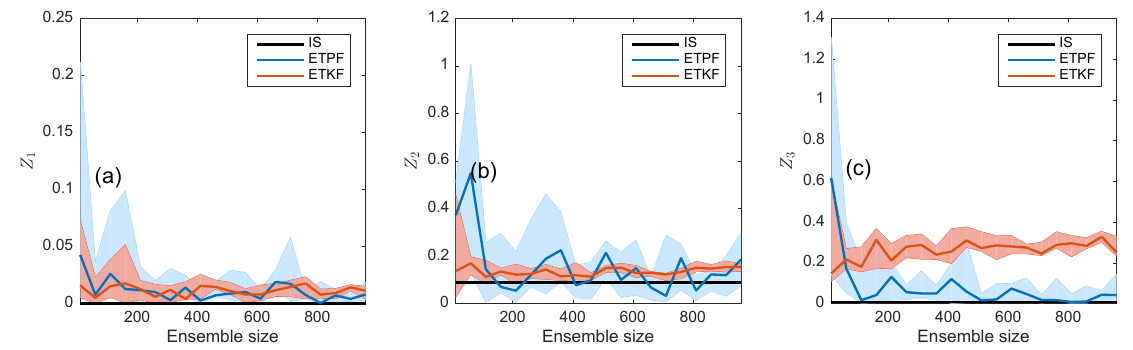
Figure 10. Squared error between the true and mean estimated modes for Z 1 (a) , Z 2 (b) , and Z 3 (c) w.r.t. ensemble size. ETPF is shown in blue and ETKF in red, with solid lines for median and shaded area for the 25th and 75th percentiles over 10 simulations. IS with ensemble size 10 5 is in black.